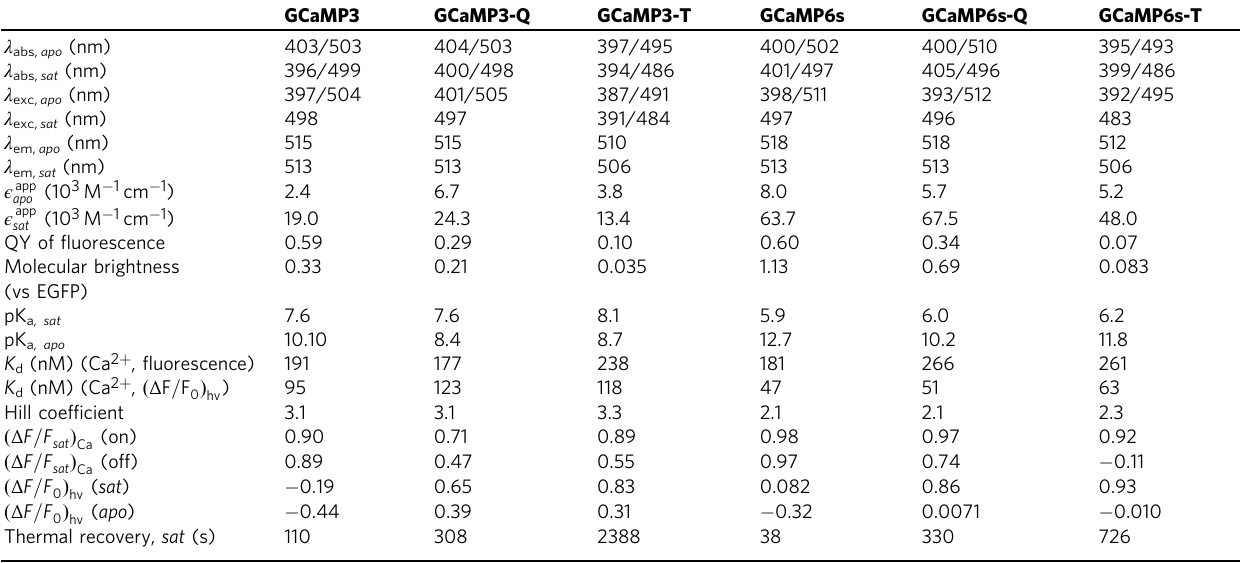
Table 1 Spectroscopic properties of GCaMP3, GCaMP6s and their -Q and -T mutants.